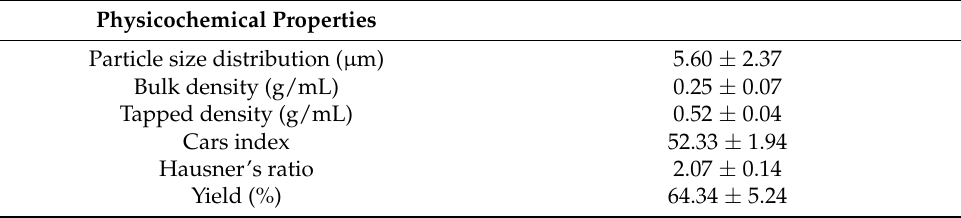
Figure 2. The SEM photographs of nanoparticles admixed with lactose microspheres as a carrier. Table 3. Physicochemical characteristics of spray-dried lactose microparticles.